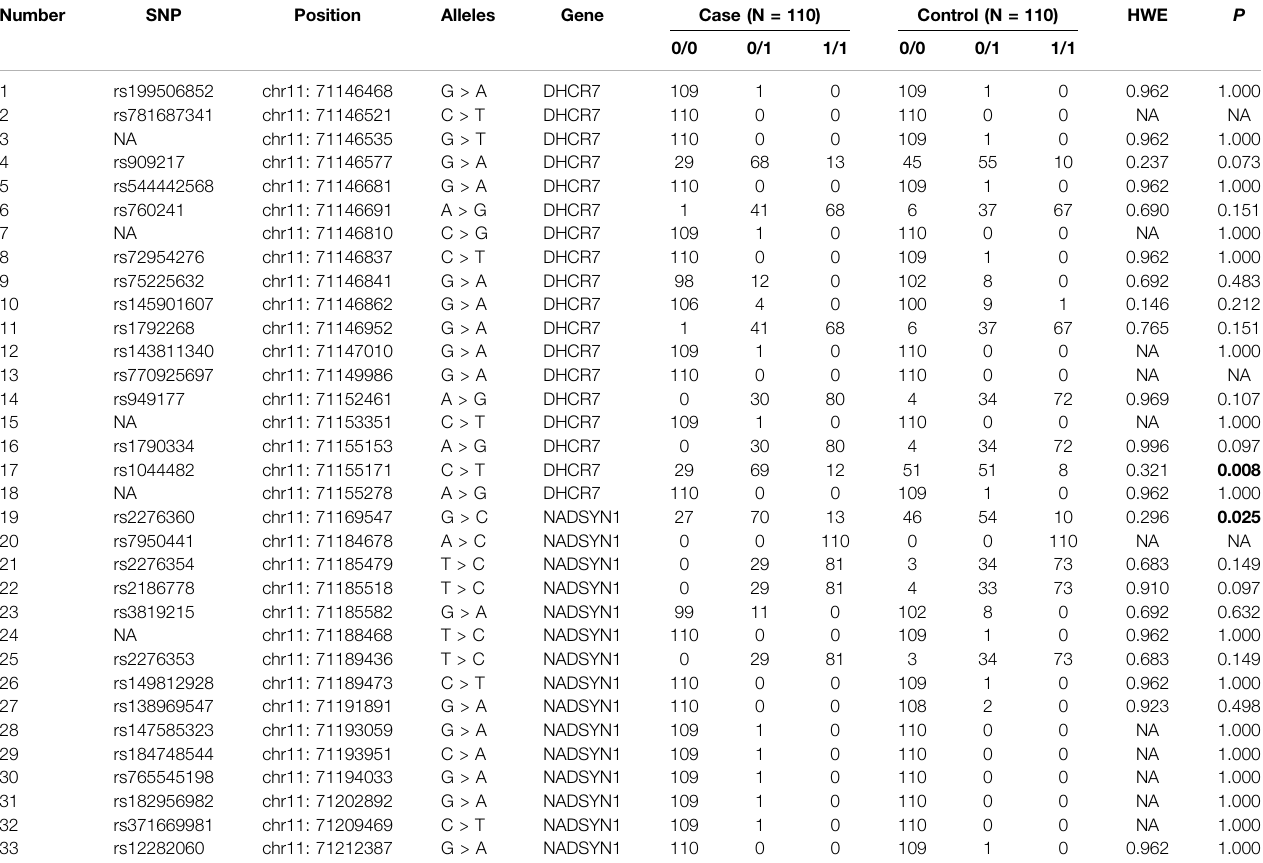
TABLE 1 | The sequencing results of 33 SNPs of DHCR7 and NADSYN1 in 110 ULs and 110healthy